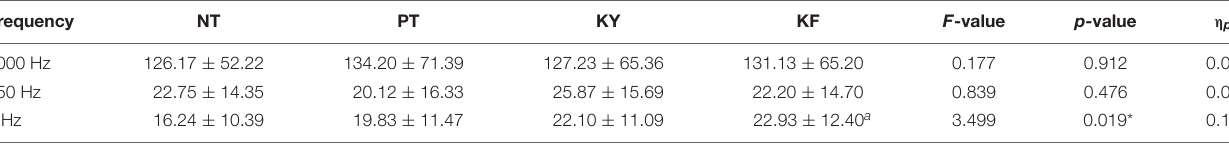
FIGURE 2 | Comparison of different taping methods in terms of CPT, PPT, Hardness, and VAS scores ( ¯ x ± s ). (A) Different taping methods in terms of CPT with 2000 Hz; (B) different taping methods in terms of CPT with 250 Hz; (C) different taping methods in terms of CPT with 5 Hz; (D) different taping methods in terms of PPT; (E) different taping methods in terms of soft tissue hardness; and (F) different taping methods in terms of visual analogue scores. *Significant difference between groups, p < 0.05. TABLE 2 | Comparison of the different taping methods in terms of CPT ( ¯ x ± s ; 1 CPT = 0.01